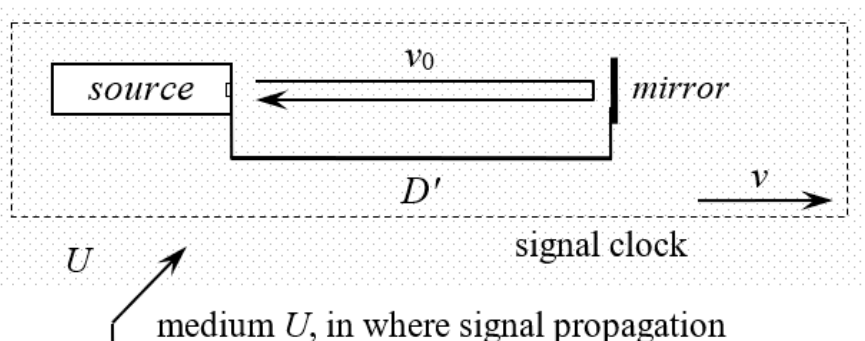
Figure 1. The signal clock is based on the signal propagating in the distinguished reference system. The clock consists of a signal source and a mirror that can reflect such a signal. The signal source and the mirror are rigidly connected at D (cid:48) distance and form the arm of a clock. The signal is sent from the source and travels a distance of D (cid:48) length. Then it is reflected by the mirror and returns to the source along the same path. When the signal returns to the source, another signal is sent immediately. This means that the signal clock continuously generates further signals. The total time of one signal passing to the mirror and back is a time standard for an observer in the same inertial system U (cid:48) in which the clock is located. The duration of one cycle of a signal clock is the smallest unit of time that a signal clock can